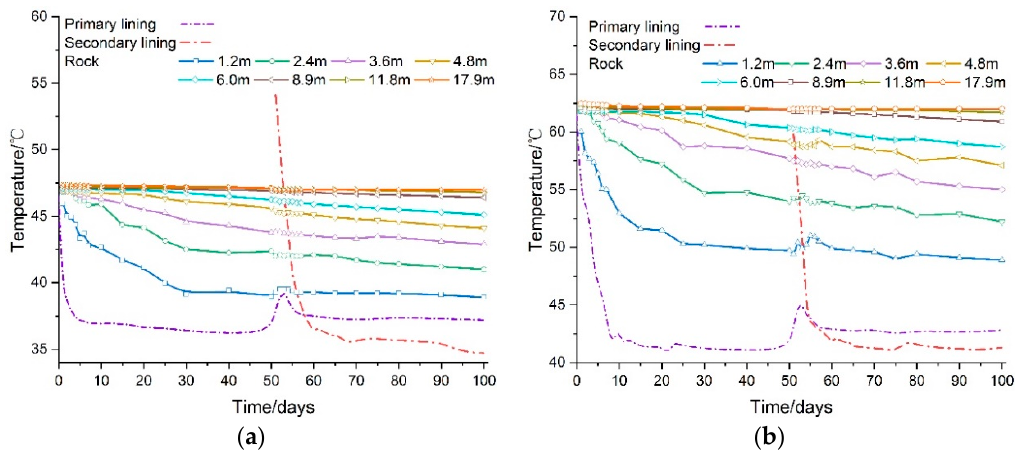
Figure 8. Variation in temperature of the surrounding rock and lining structure during construction: (a) Test Location 1 and (b) Test Location 2.